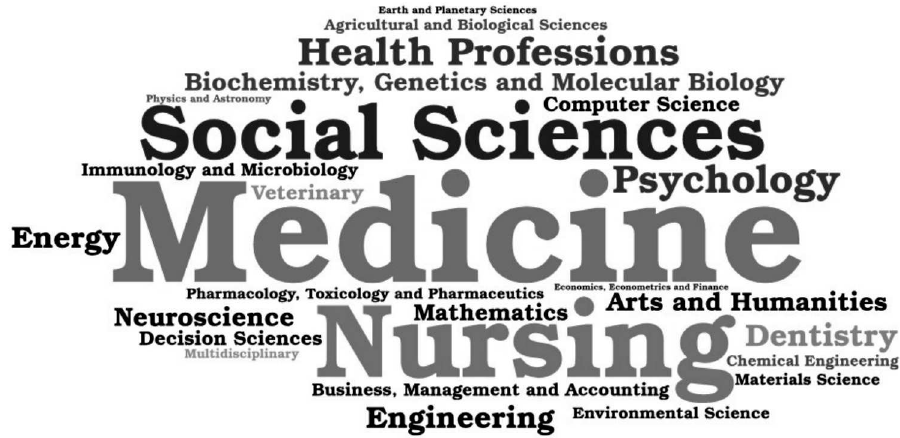
Figure 4. Scientific areas related to quality management of medical